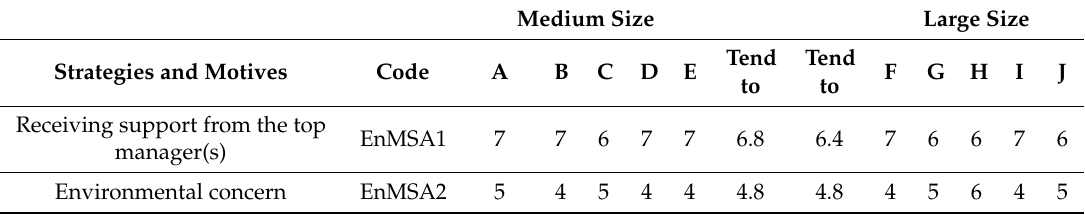
Table 1. Results for energy management system assessment (EnMSA) for both medium- and large-sized companies (1 = Strongly Disagree, 4 = neither Agree nor Disagree, 7 = Strongly